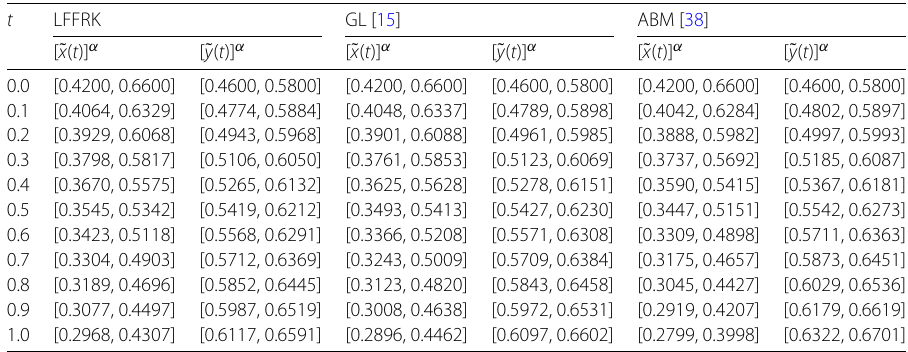
Table 3 Solutions of system (13) with the comparison to GL and ABM for σ = 0.95, α =